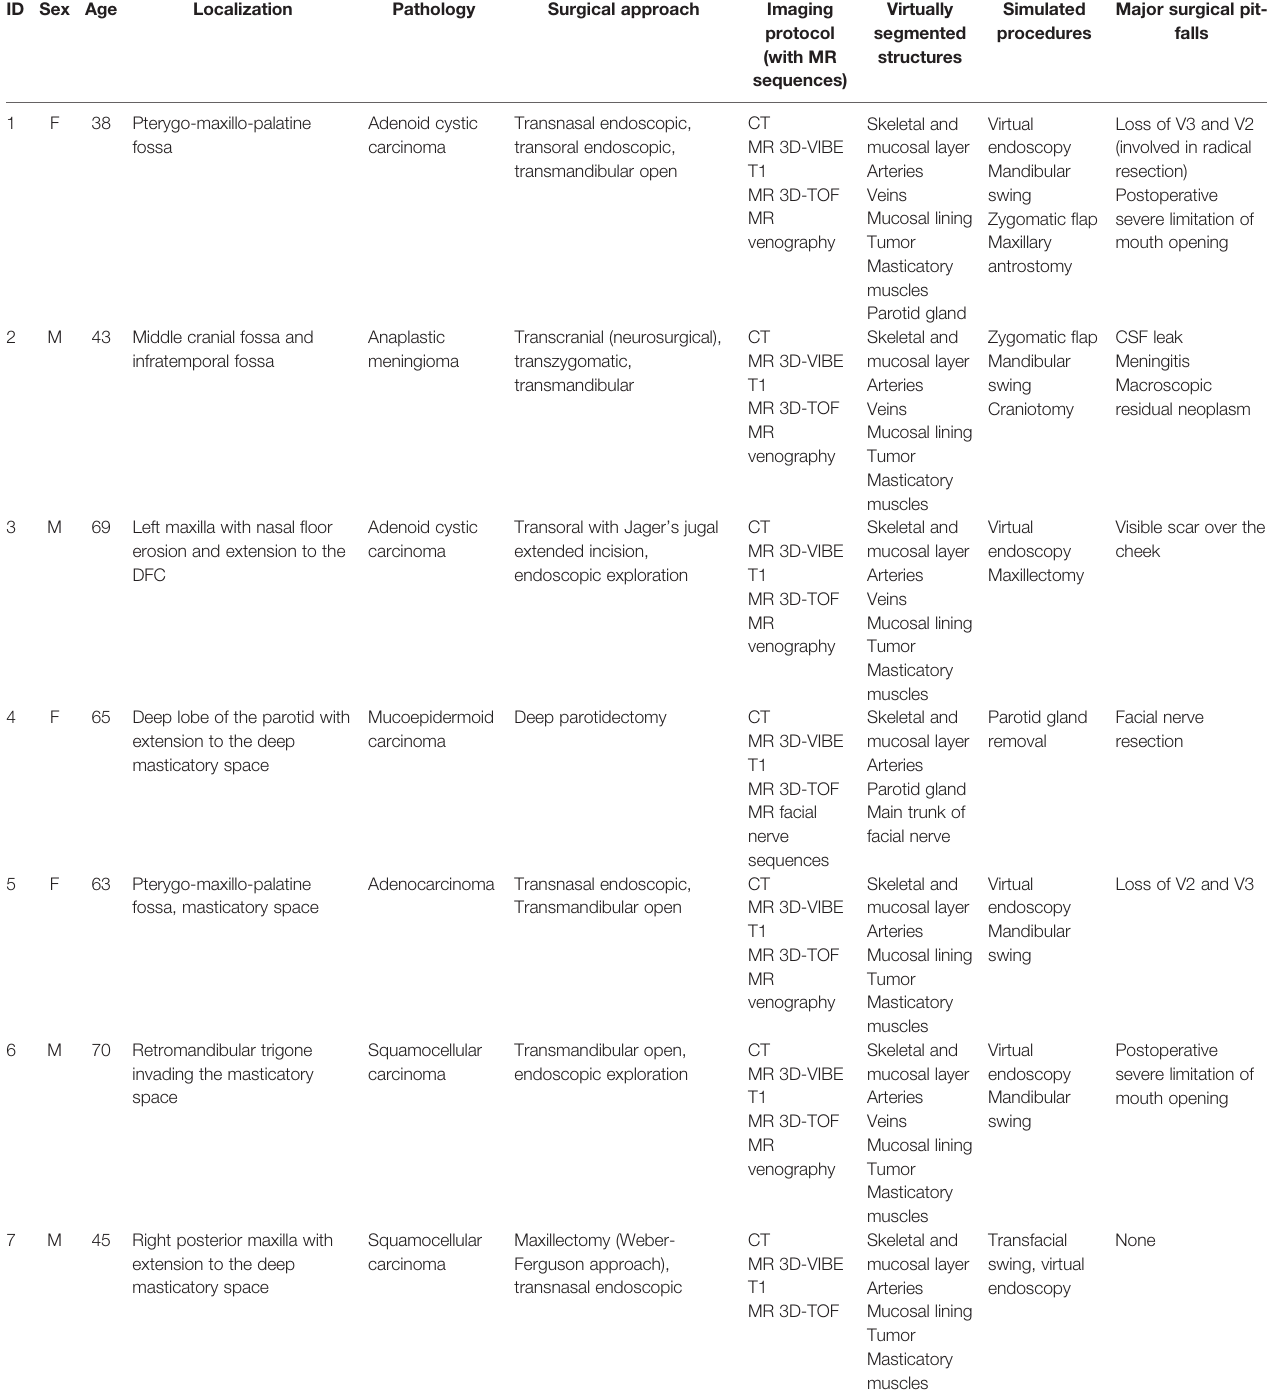
TABLE 1 | Characteristics of patients in relation to disease process, surgery, and protocol